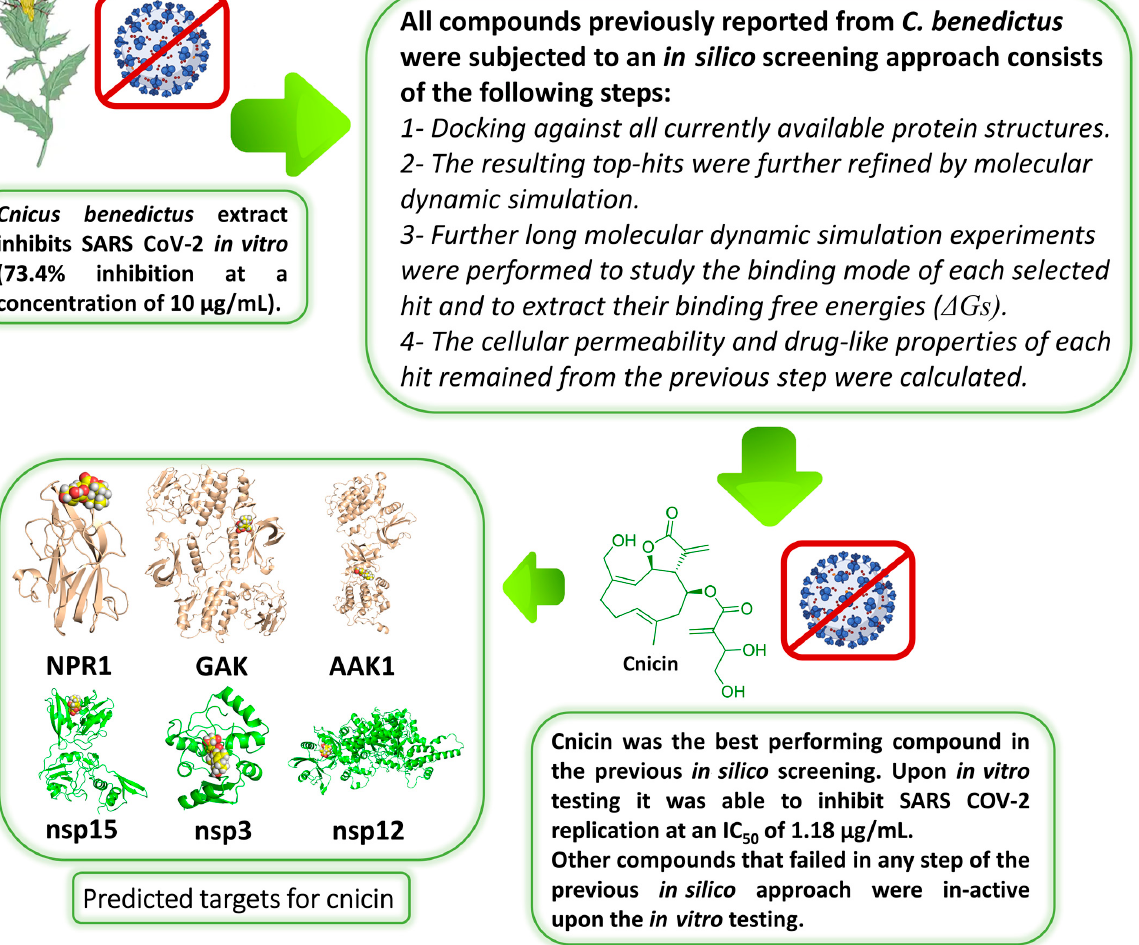
Figure 2. The workflow of the current study.